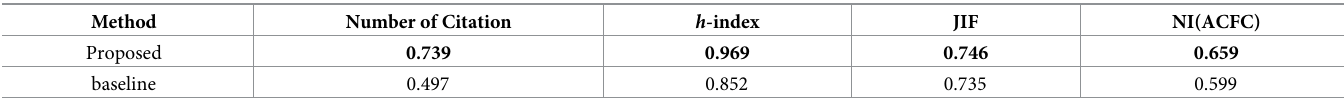
Table 9. Results of emerging research area identification (AUC).